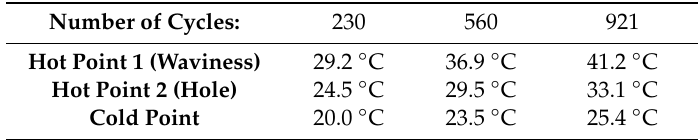
Table 1. Surface temperature for control points of the specimen cut in transversal direction with geometry A.